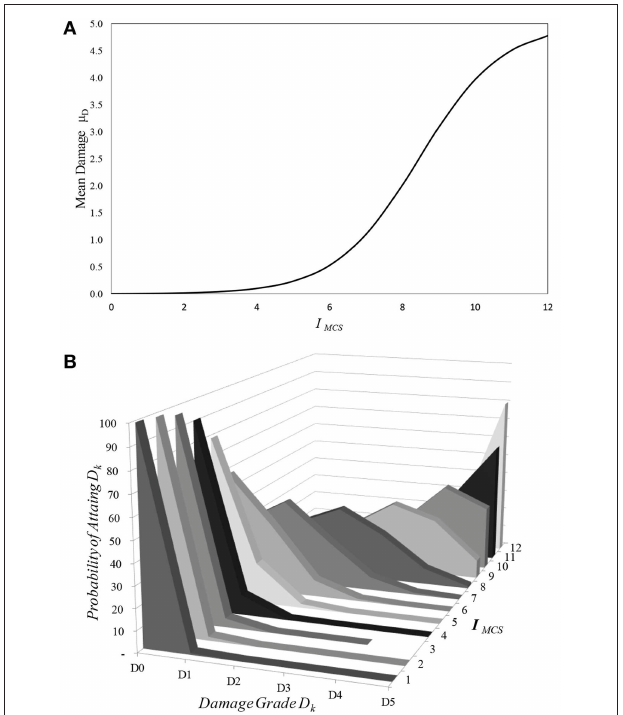
FIGURE 10 | (A) Expected mean Damage ( µ D ) vs. Earthquake Intensity (I MCS ) and (B) the related Damage Probability Matrices.